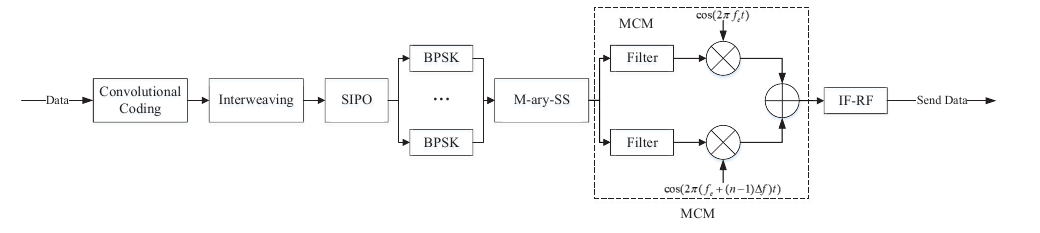
Figure 12. STX system block diagram.